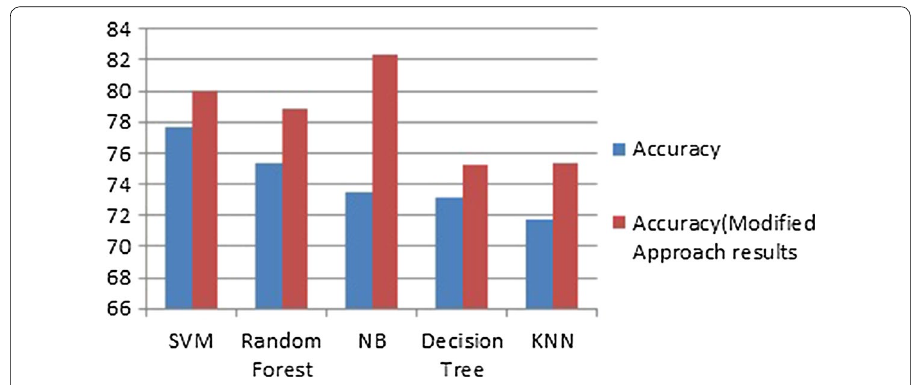
Fig. 12 Comparison of classification